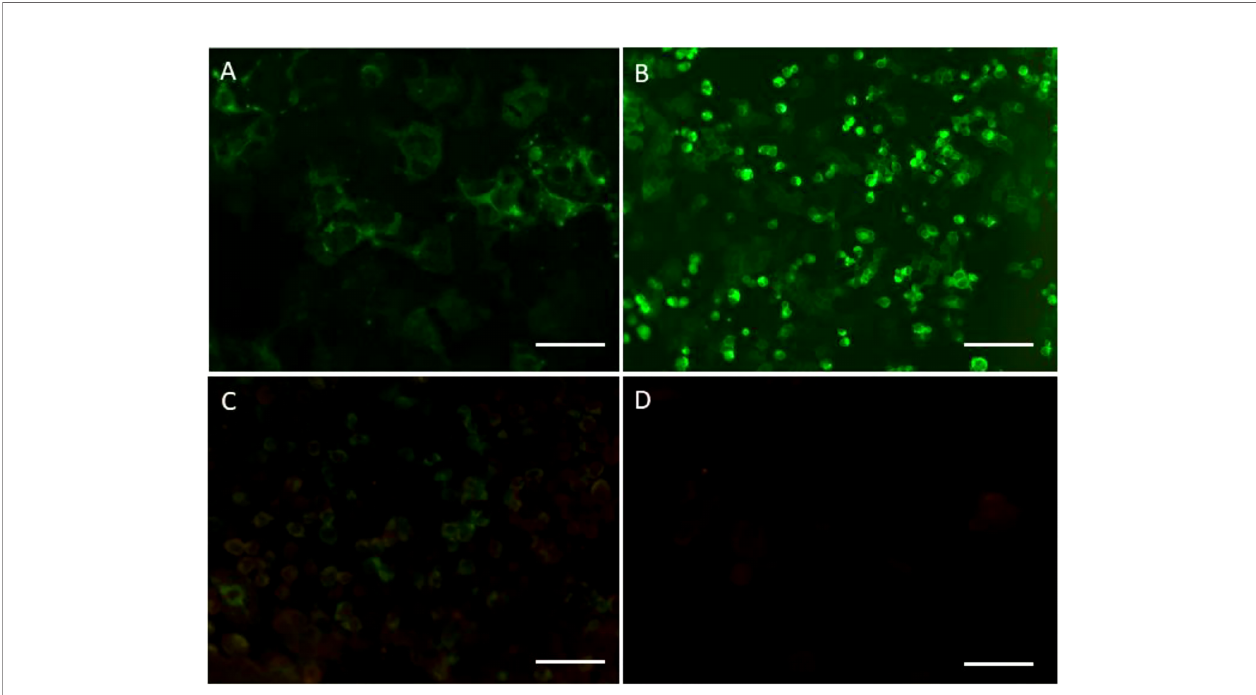
FIGURE 2 | (A) Cerebrospinal fl uid (CSF) showing the binding to the surface of the cells expressing anti-NMDAR receptors (NMDAR) (1:10) (scale bar 20 m m). (B) Myelin oligodendrocyte glycoprotein (MOG) antibodies (1:32) were detected in the CSF (scale bar 100 m m). (C) MOG antibodies (1:1) were detected in serum (scale bar 100mm). (D) GFAP antibodies were found negative in the CSF (scale bar